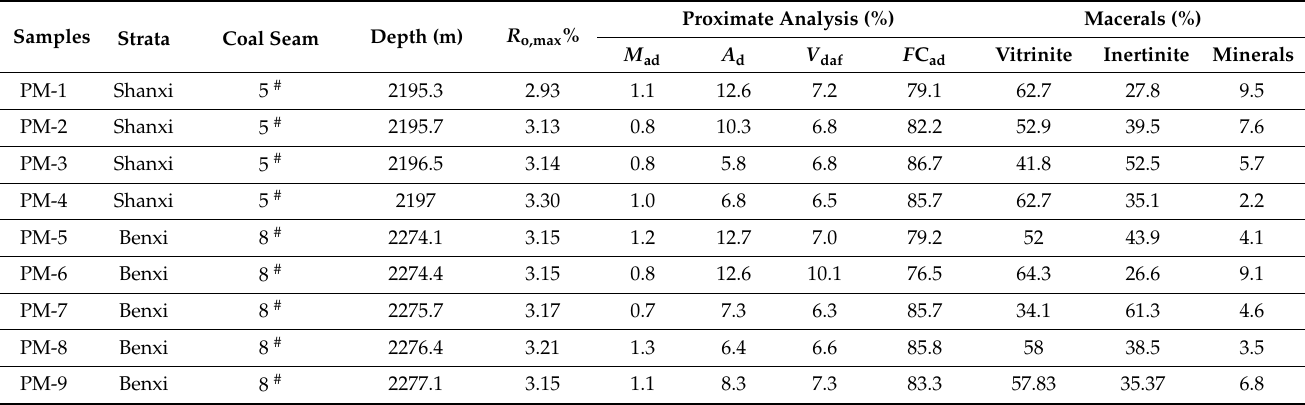
Table 1. Basic characteristics of coal